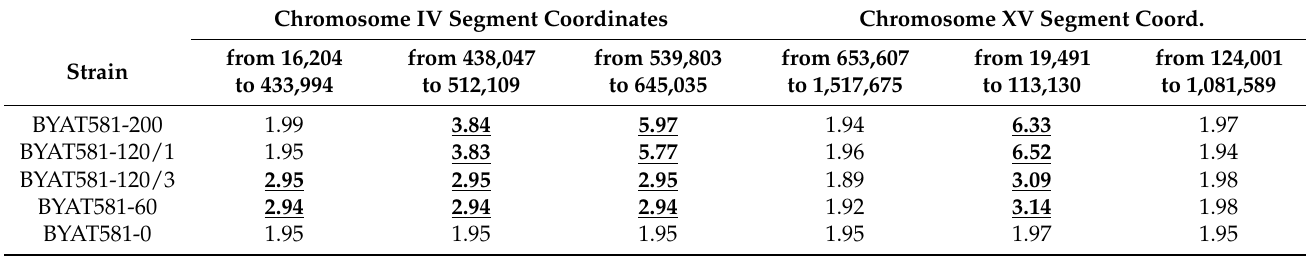
Table 2. Calculation of precise copy numbers per cell of selected chromosome segments. Chromosome IV Segment Coordinates Chromosome XV Segment